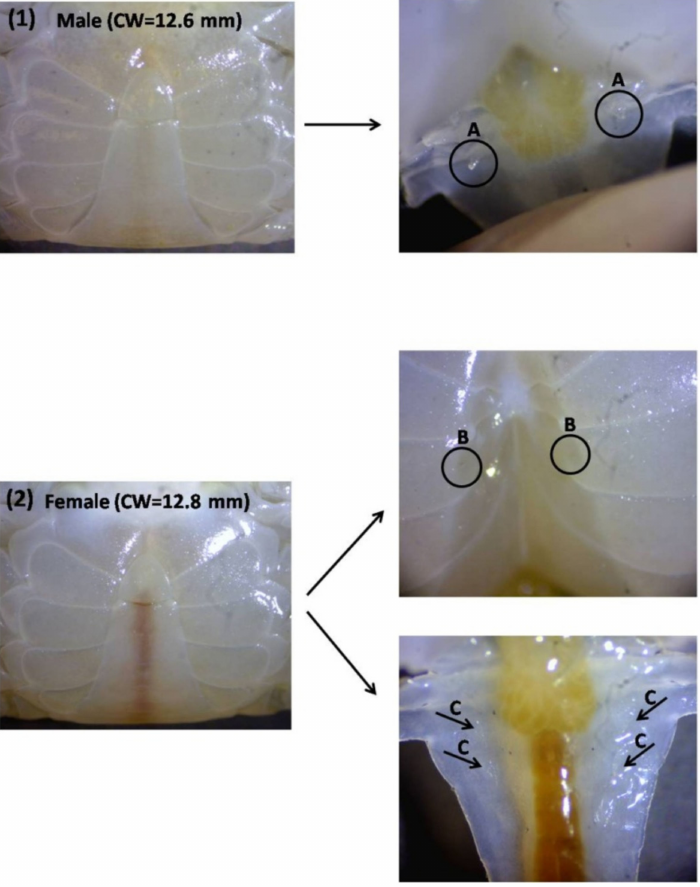
Figure 2. The appearance of the abdominal flap of mud crab crablets S. paramamosain (male and female). ( A ) gonopod (copulatory pleopods), ( B ) gonopore and ( C ) biramous